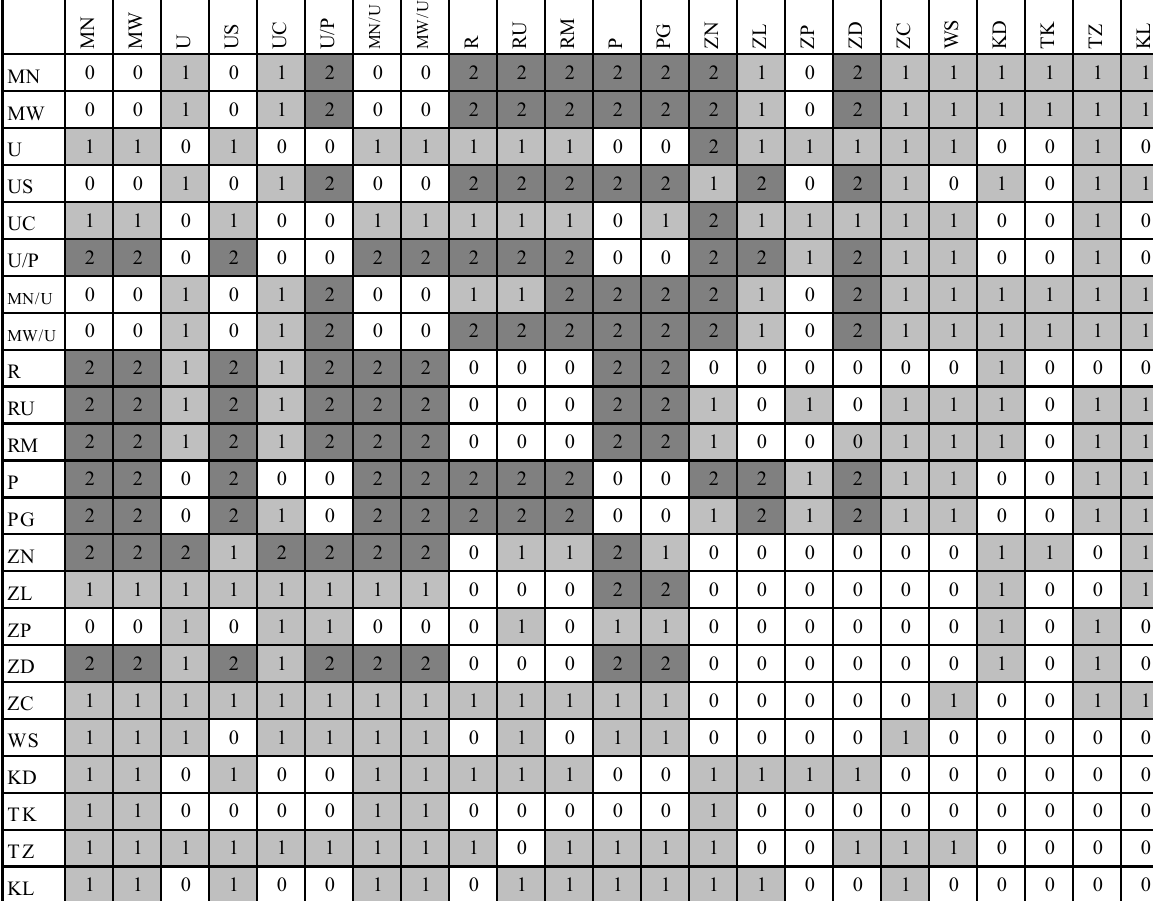
Table 1. Compatibility matrix of land use